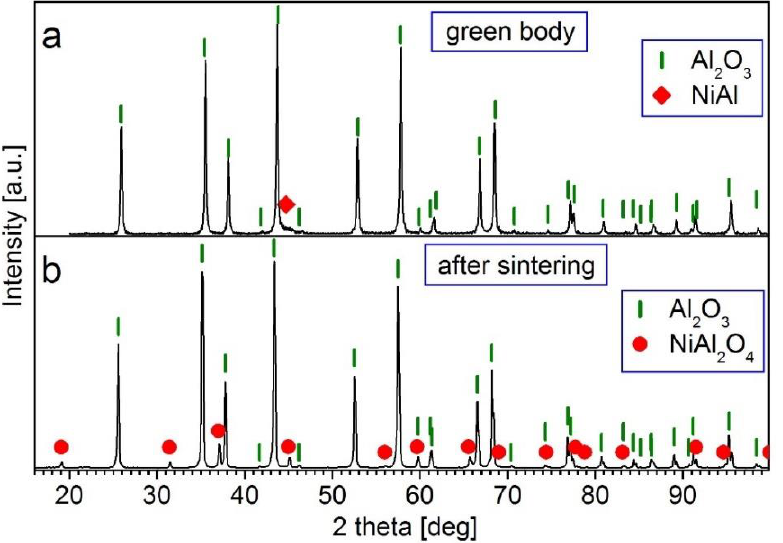
Figure 9. XRD patterns of the Al 2 O 3 + 2.5 vol.% of (NiAl + 30 wt.% A 2 O 3 ) sample: ( a ) green body; ( b ) after sintering at 1450 °C for 2 h.